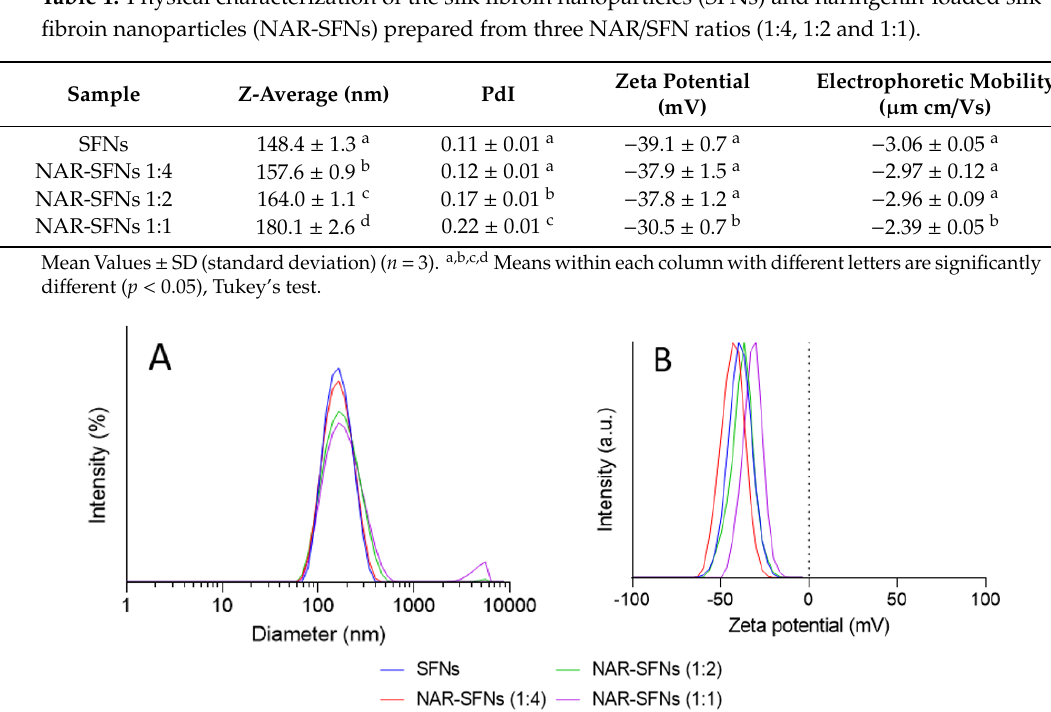
Table 1. Physical characterization of the silk fibroin nanoparticles (SFNs) and naringenin-loaded silk